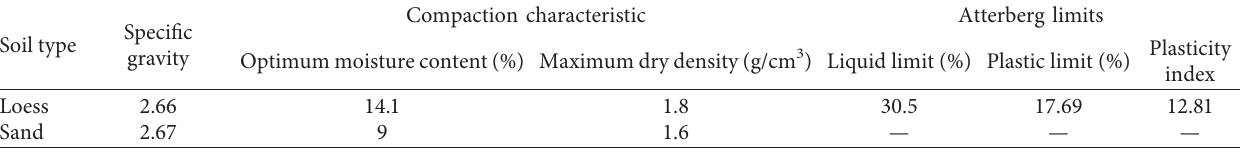
u ) and curvature (C c ) for